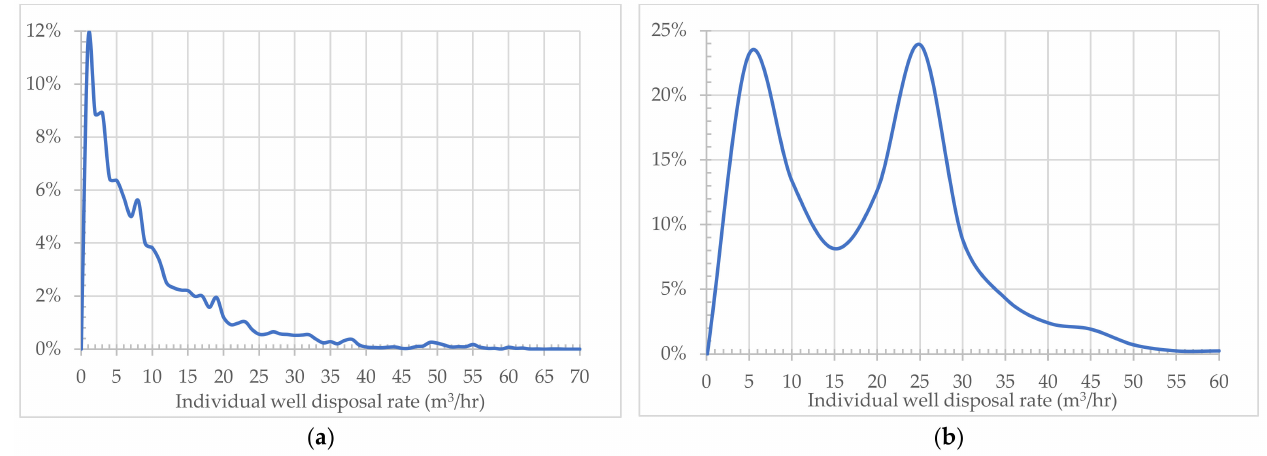
Figure A24. Historical per-well water injection rate ( X -axis) frequency ( Y -axis) distributions (January 1962–December 2022) in ( a ) the Banff Formation; ( b ) the Blueridge